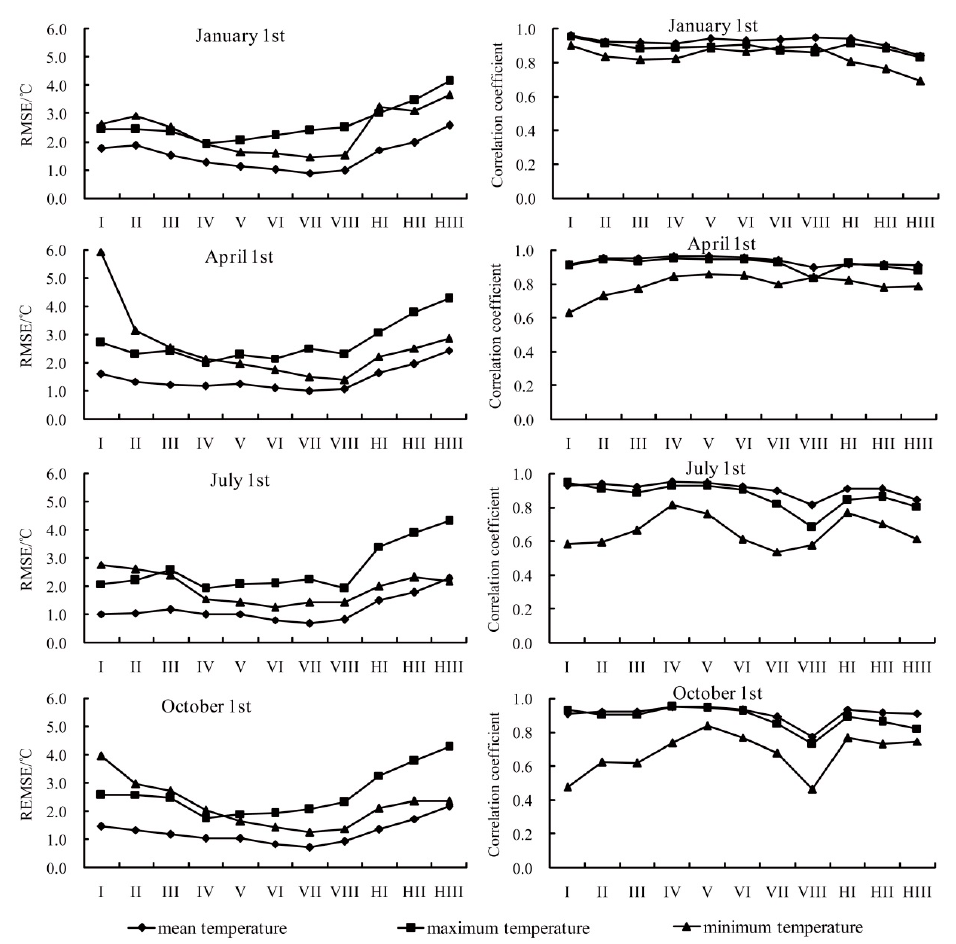
Figure 2. Root mean-square error (left) and correlation coefficient (right) of daily temperature for January 1st, April 1st, July 1st and October 1st.